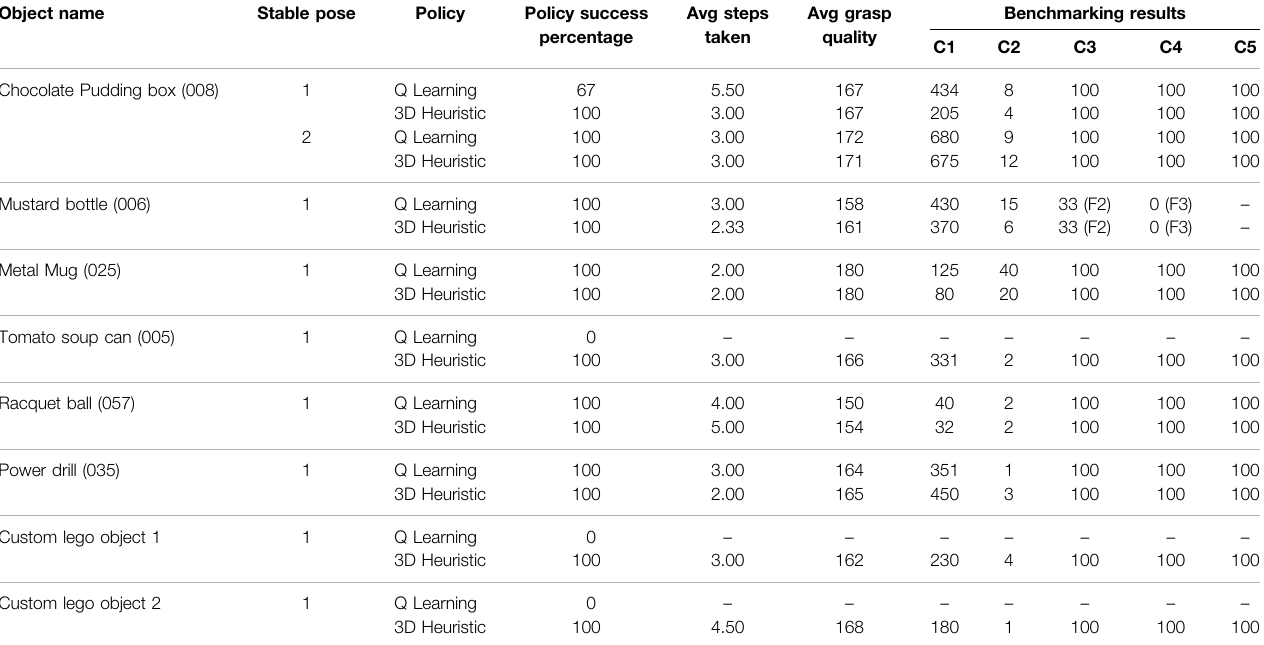
TABLE 2 | A list of objects tested for 3D Heuristic and QLearning policies along with the benchmarking results. Object